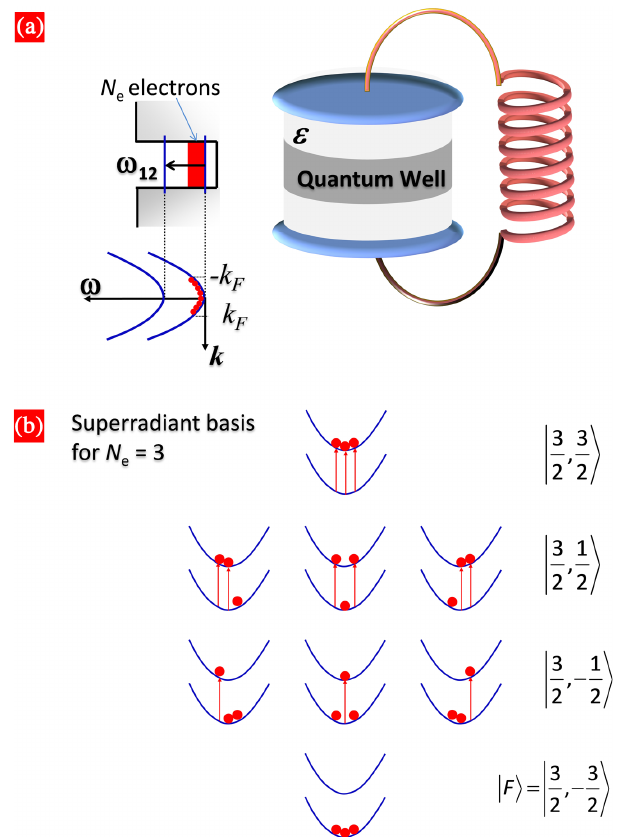
FIG. 2. (a) Illustration of a quantum well inserted into the capacitive part of an LC resonator and interacting with the quasistatic electric field of the capacitor. The QW is intentionally doped such that there is a two-dimensional electron gas on the first subband of the well. The energy difference between the first and the second subband, ℏ ω 21 , is matched with the resonance of the LC circuit, ℏ ω c . (b) Mapping of the Dicke states j J; M i into the possible excited states of the QW in the case of N e ¼ 3 electrons in the